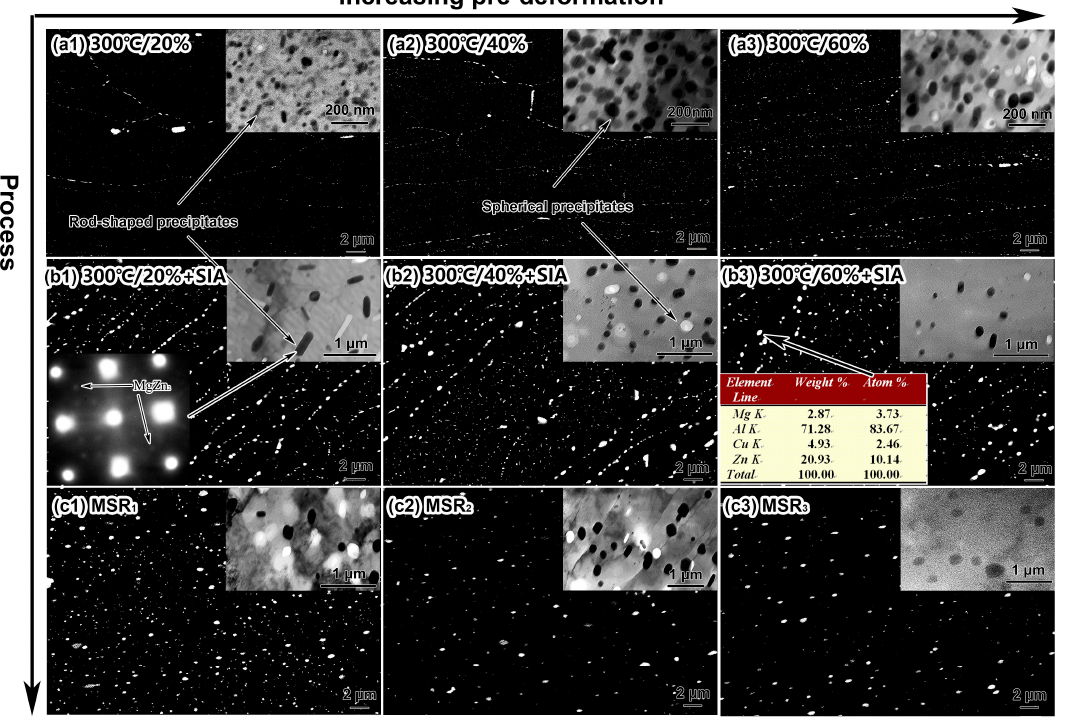
Figure 3. SEM images (by backscattered electron) with embedded TEM images of precipitates: ( a1 ) 300 °C/20%; ( a2 ) 300 °C/40%; ( a3 ) 300 °C/60%; ( b1 ) 300 °C/20% + SIA (with embedded SAED (selected area electron diffraction) patterns); ( b2 ) 300 °C/40% + SIA; ( b3 ) 300 °C/60% + SIA (with embedded EDS results); ( c1 ) MSR 1 ; ( c2 ) MSR 2 ; ( c3 ) MSR 3 .